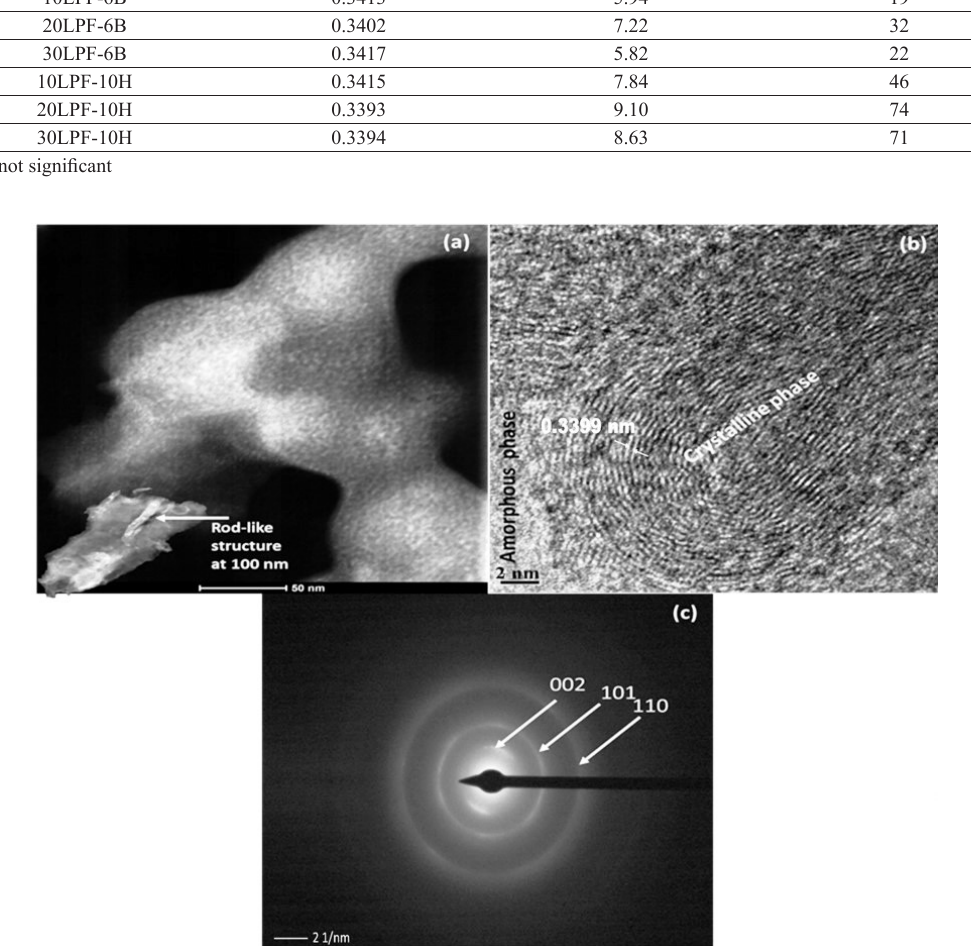
Figure 6. (a) TEM, (b) HRTEM and (c) SAED images of 20LPF-10H carbon sample prepared using sequential heat treatment process up to 1500